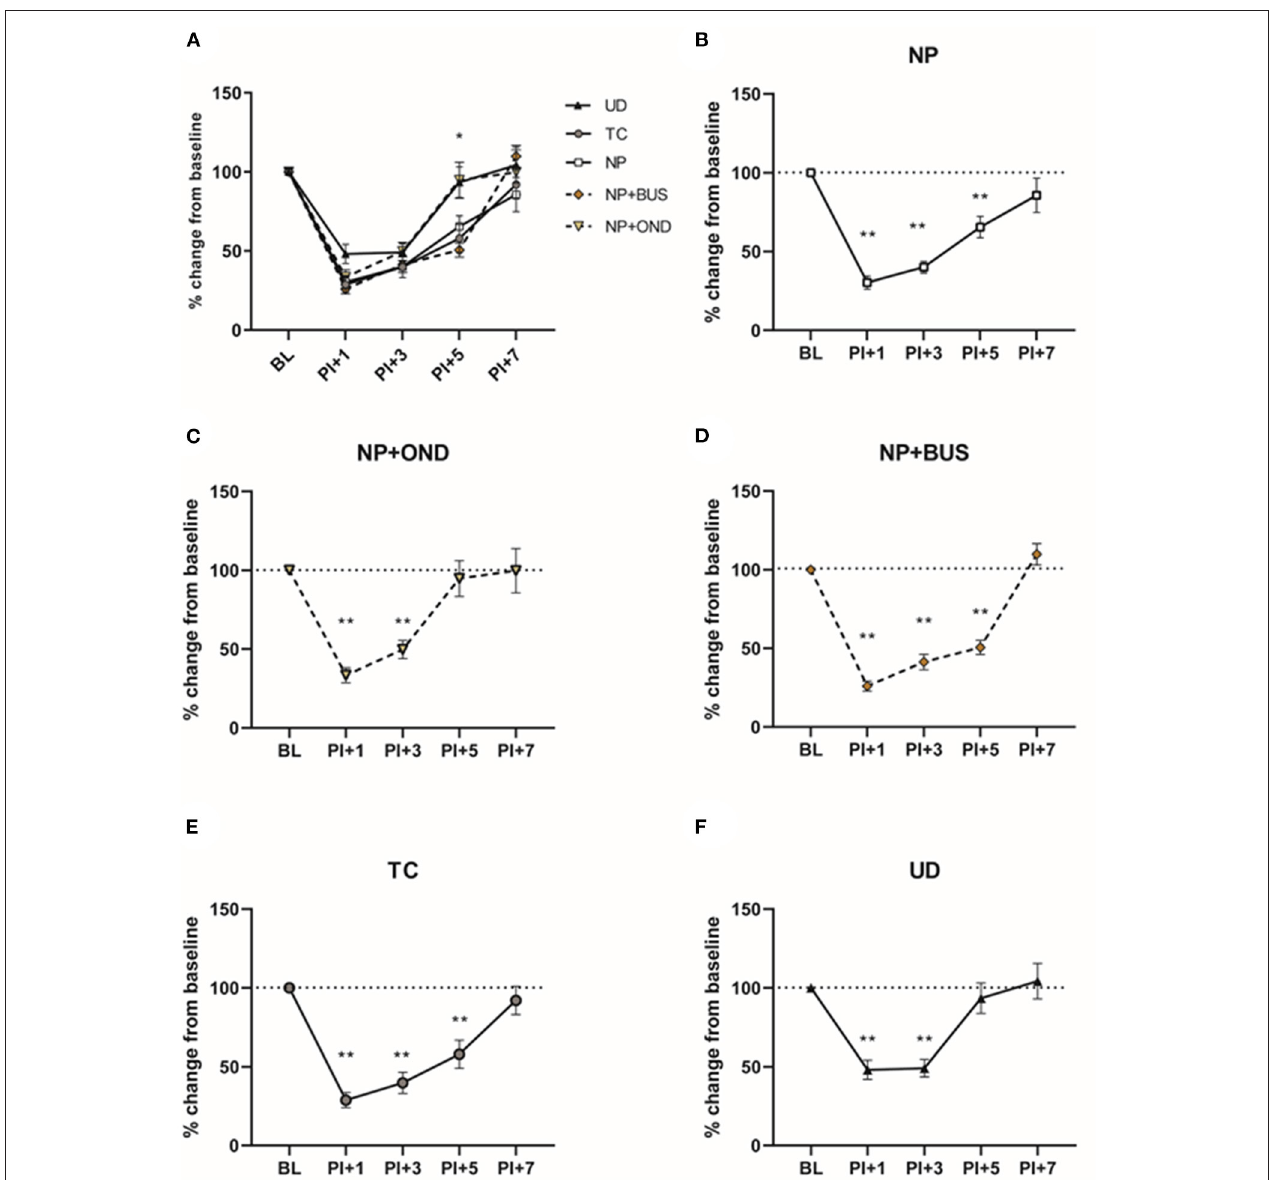
FIGURE 5 | Mechanical sensitivity after re-injury in adulthood. (A) All groups show mechanical hypersensitivity 1 and 3 days after incision in adulthood, but differences emerge between groups at 5 and 7 days post-incision. Return to pre-operative base-line PWT levels is noted in UD animals by 5 days postoperative (F) , while PWTs of NP (B) and TC animals (E) are recovered to pre-operative baseline by 7 days postoperative. NP + OND (D) , but not NP + BUS (C) , abolishes this longer recovery time after incision. BL, baseline; NP, needle prick animals; NP + OND, needle prick animals receiving ondansetron; NP + BUS, needle prick animals receiving buspirone; PI, paw incision, + 1, + 3, + 5; measurement 1, 3, and 5 days after paw incision; TC, tactile stimulation animals; UD, undisturbed control animals. Data is presented as mean ± SEM, * P < 0.05, ** P < 0.01 as compared to their respective